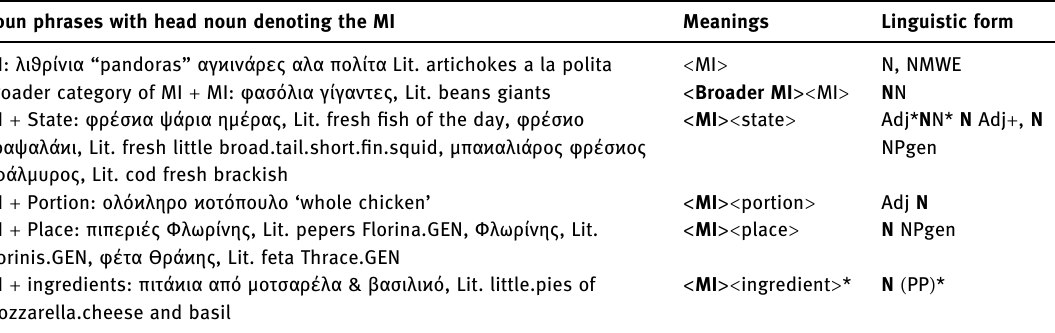
Table 1: Dish names headed by a noun denoting the MI. Modi fi ers may denote MMs or other meanings Noun phrases with head noun denoting the MI Meanings Linguistic